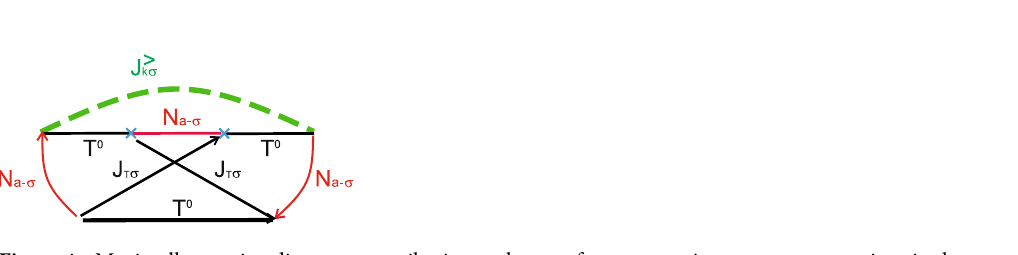
Figure 4. Maximally crossing diagrams contributing to the zero frequency noise quantum corrections in the T 0 a −